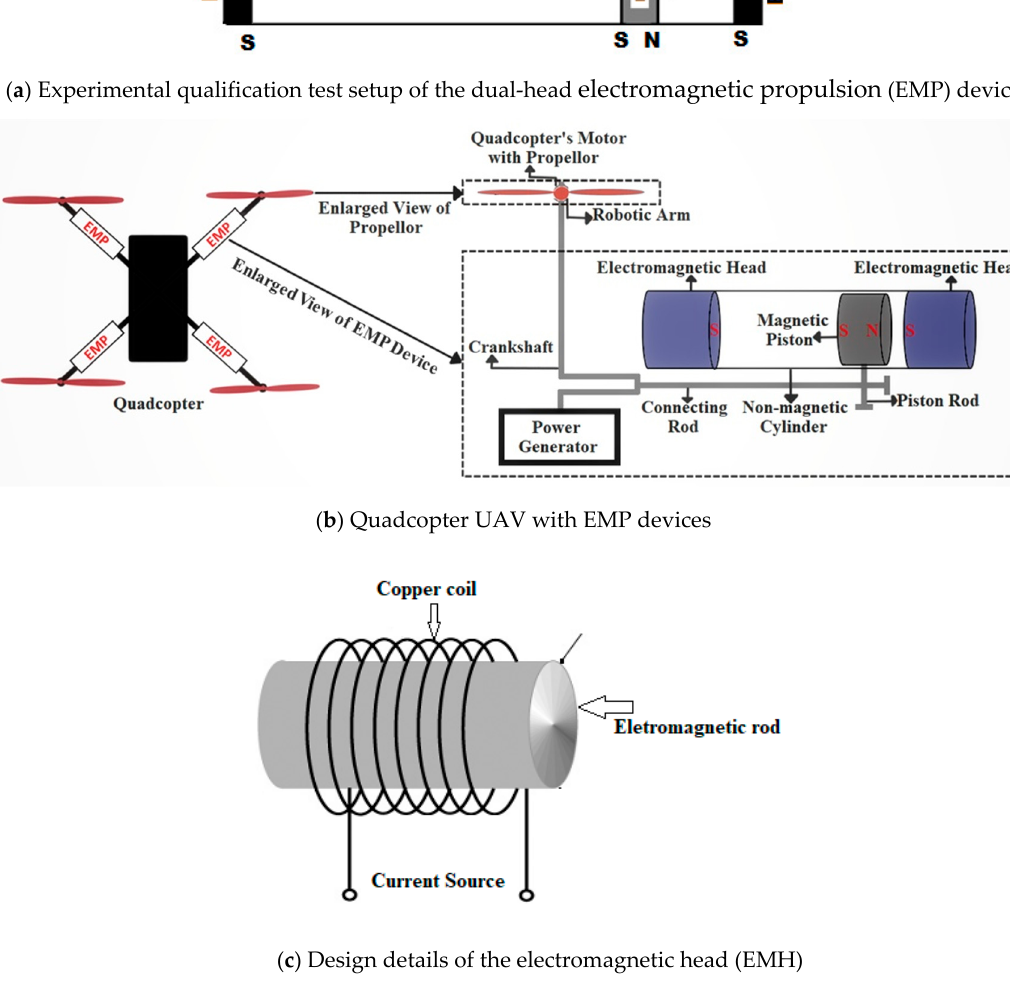
Figure 13. ( a – c ) Ground testing and design details of the quadcopter unmanned aerial vehicle (UAV) with dual ‐ head EMP devices.